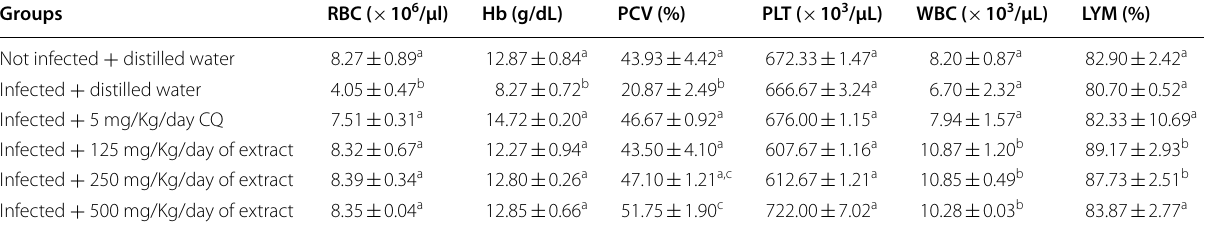
Values are mean S.E.M ( n 8). Values with different alphabet superscripts in the same column are significantly different ( P < 0.05) ± = CQ chloroquine, RBC red blood cells count, Hb haemoglobin concentration, PCV packed cell volume, PLT platelet count, WBC white blood cells count, LYM (%) relative lymphocytes